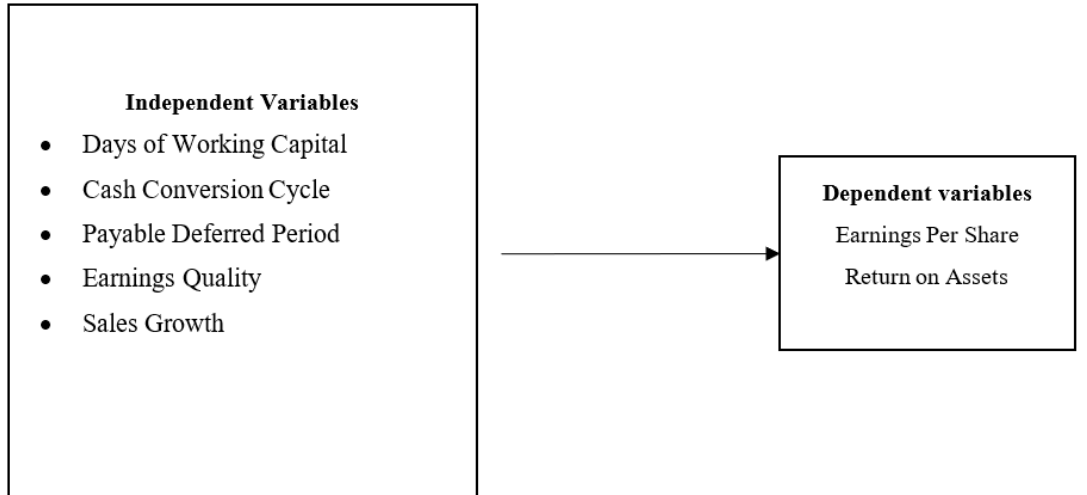
Figure 1. Conceptual model of the study. Source: constructed by authors.